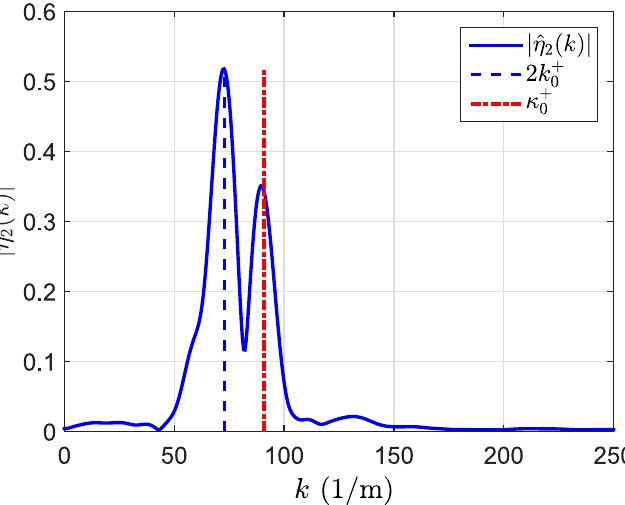
Figure 13. Amplitude of the second harmonic η 2 ( k ) as a function of wave number. Non-dimensional wavenumber of the linear mode is k + h + = 0.73. Vertical lines indicate the wavenumber expected 0 from the dispersion relation of water waves in Equation